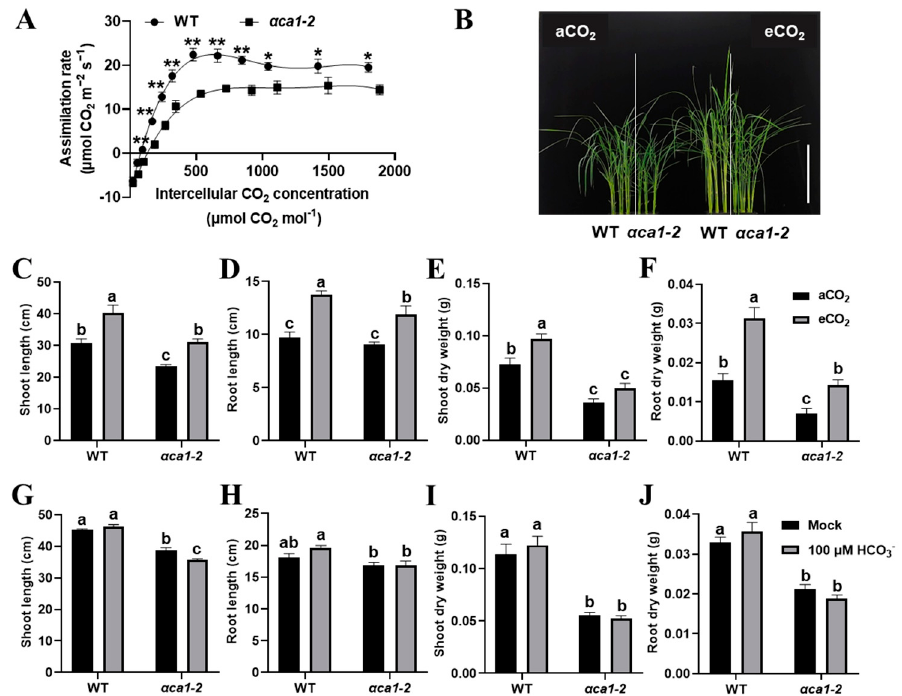
Figure 7. The distinct responses of α ca1-2 growth to elevated CO 2 and HCO 3 − treatments. ( A ) The CO 2 response curve of WT and α ca1-2 . The first expanded leaf of 2-week-old seedlings was measured. All values are shown as means ± SEM determined via Student’s t -test, where * p < 0.05, ** p < 0.01, no asterisk indicates no significant difference, and n ≥ 9. ( B ) The representative image of WT and α ca1-2 seedlings under aCO 2 and eCO 2 conditions. Scale bar: 15 cm. ( C – F ) The plant growth of WT and α ca1-2 under aCO 2 and eCO 2 conditions. ( C ) Shoot length; ( D ) root length; ( E ) dry weight of shoot; ( F ) dry weight of root. After germination, seedlings were cultured under aCO 2 and eCO 2 for 2 weeks. aCO 2 —ambient CO 2 , 400 ppm; eCO 2 —elevated CO 2 , 1000 ppm. ( G – J ) The plant growth of WT and α ca1-2 after 100 µM NaHCO 3 treatment. ( G ) Shoot length; ( H ) root length; ( I ) dry weight of shoot; ( J ) dry weight of root. One-week-old seedlings were treated with or without 100 µM of NaHCO 3 for two weeks. Values are shown as means ± SEM in ( C – J ) determined via two-way ANOVA, where di ff erent le tt ers indicate a signi fi cant di ff erence, p < 0.05, and n ≥ 20.